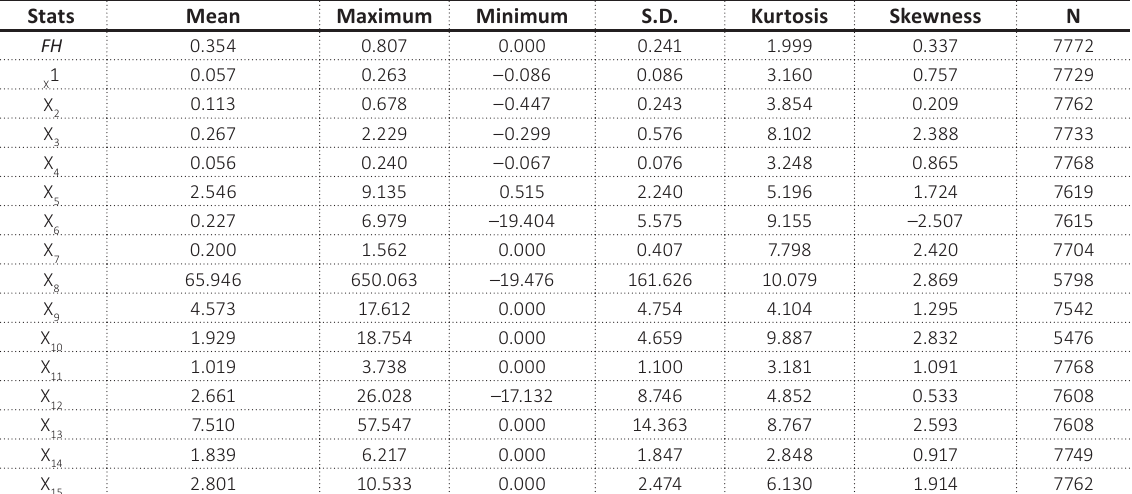
Table 3. Descriptive statistics of the selected